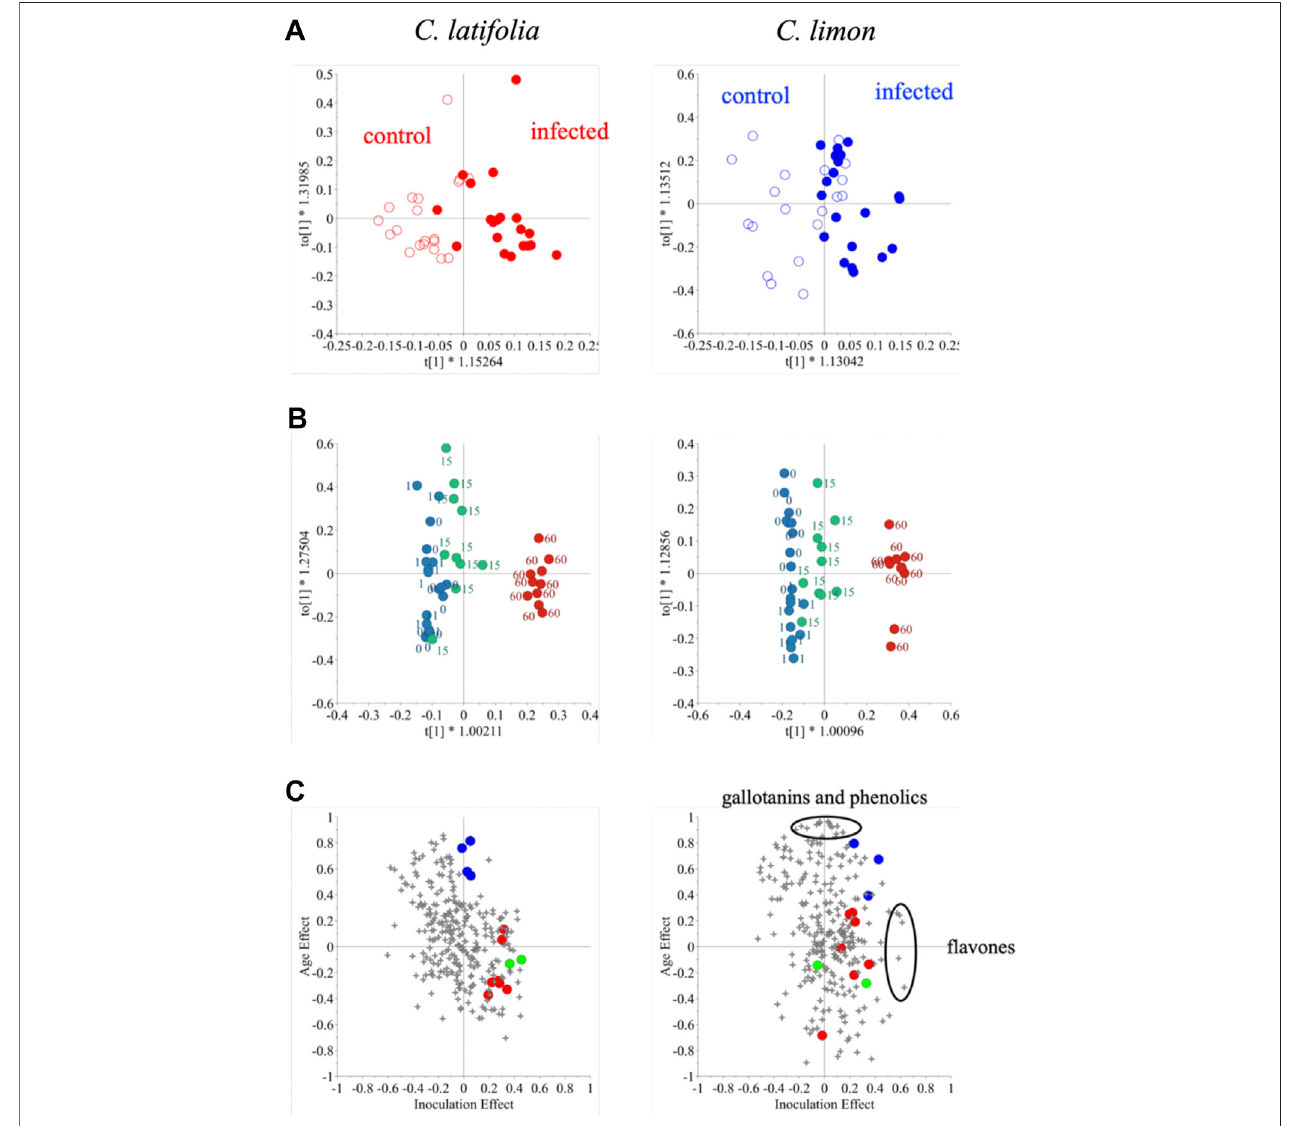
FIGURE 4 | Orthogonal partial least square analysis – discriminant analysis of 1 H NMR spectra of Citrus latifolia and Citrus limon for the inoculation effect (A) orthogonal partial least square analysis of the same dataset for the days post inoculation (dpi) effect (B) , and shared and unique structures (SUS)-plot for the inoculation (X-axis) and dpi (Y-axis) effect (C) of the same dataset. In Figure 4C , malic acid (